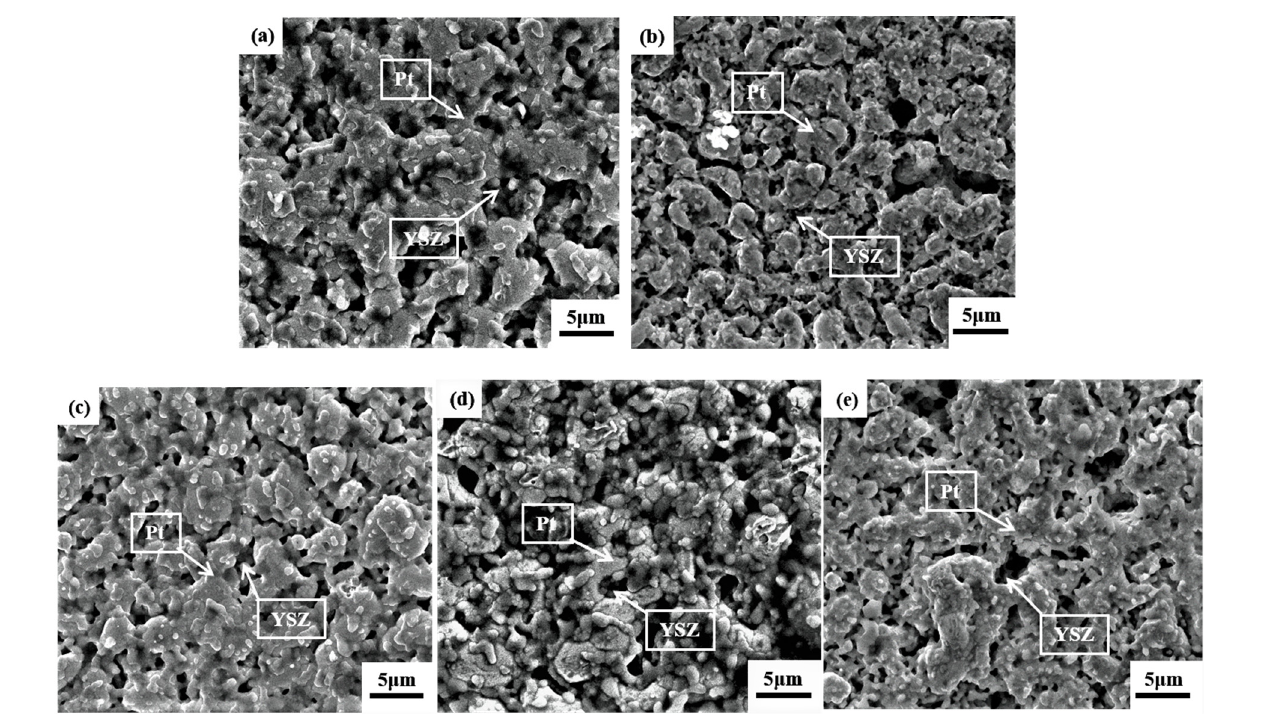
Figure 3. SEM morphologies of Pt/YSZ electrodes at different sintering temperatures ( a ) 1350 °C, ( b ) 1400 °C, ( c ) 1450 °C, ( d ) 1500 °C and ( e ) 1550 °C.